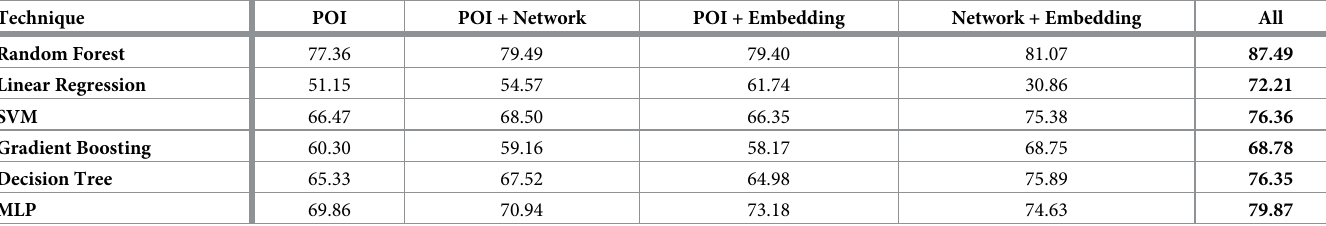
Table 2. Exploration of various machine learning techniques and feature combinations with their top performing accuracy. Technique POI POI + Network POI + Embedding Network + Embedding All Random Forest 77.36 87.49 Linear Regression 51.15 54.57 SVM 66.47 76.36 Gradient Boosting 60.30 Decision Tree 65.33 MLP 69.86